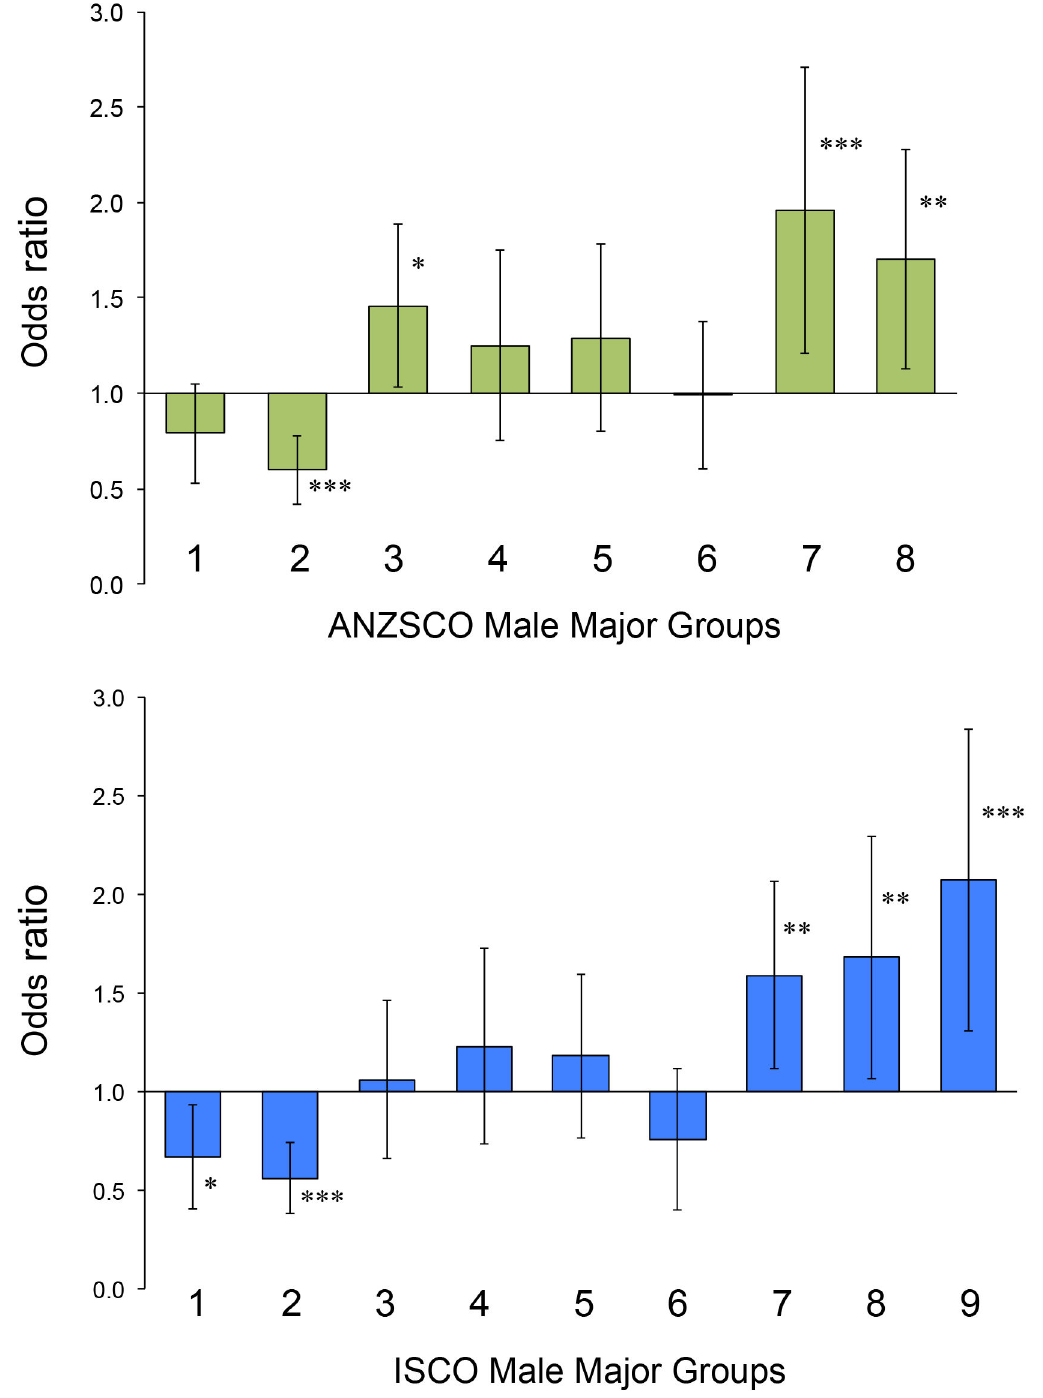
Figure 1. The risk of SALS in male Major Occupational Groups. In both ANZSCO and ISCO classifications, occupations with higher skills/tasks (on the left of the graphs) tended to have lower risks of SALS, and those with lower skills/tasks (on the right of the graphs) higher risks of SALS. 1 = Managers, 2 = Professionals, 3 = Technicians and Trade Workers, 4 = Community and Personal Service Workers, 5 = Clerical and Administrative Workers, 6 = Sales Workers, 7 = Machinery Operators and Drivers, 8 = Labourers, 9 = Elementary Occupations. Bars = 95% confidence internals. * = p <0.05, ** = p<0.01, *** = p<0.001.